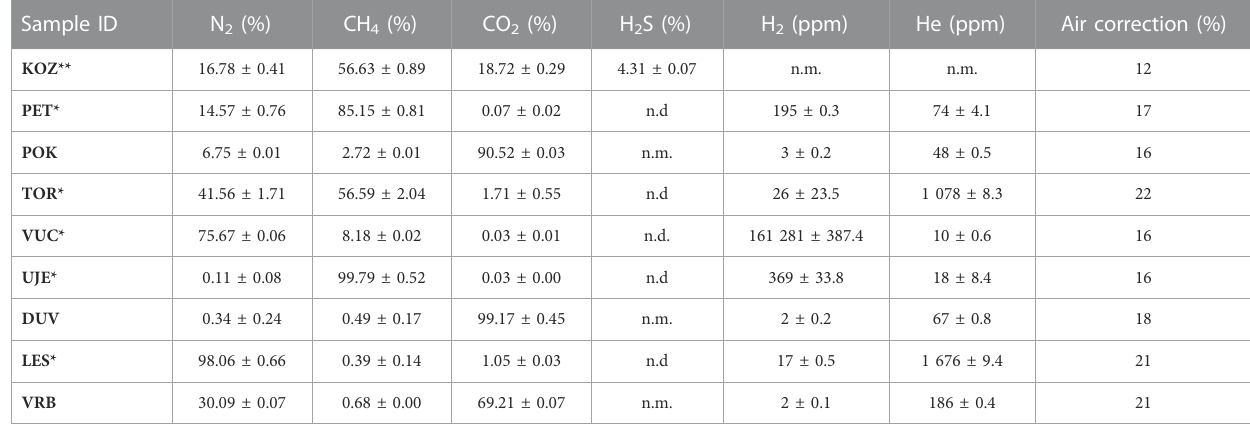
TABLE 2 Gas compositions of N 2 , CH 4 , CO 2 , H 2 S, H 2 , and He with the associated air content used for air correction. The O 2 content is not represented being at 0%. The symbol* is used on the sample ID when the analysis is an average between analyses from the GC of 45-8 Energy and ISOLAB, the symbol ** when the analysis only comes from ISOLAB and when it is only from 45-8 Energy there is not any